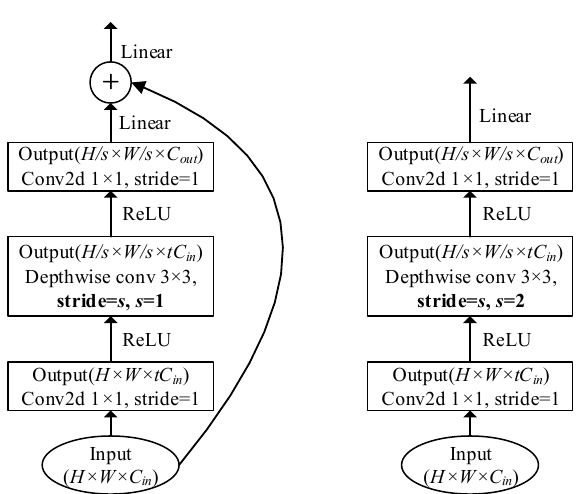
Figure 2. Structure of bottleneck convolution blocks transforming from C in input channel to C out output channels, with an expansion factor t . Left: a block for the depthwise convolution with stride = 1. Right: a block for the depthwise convolution with stride = 2.